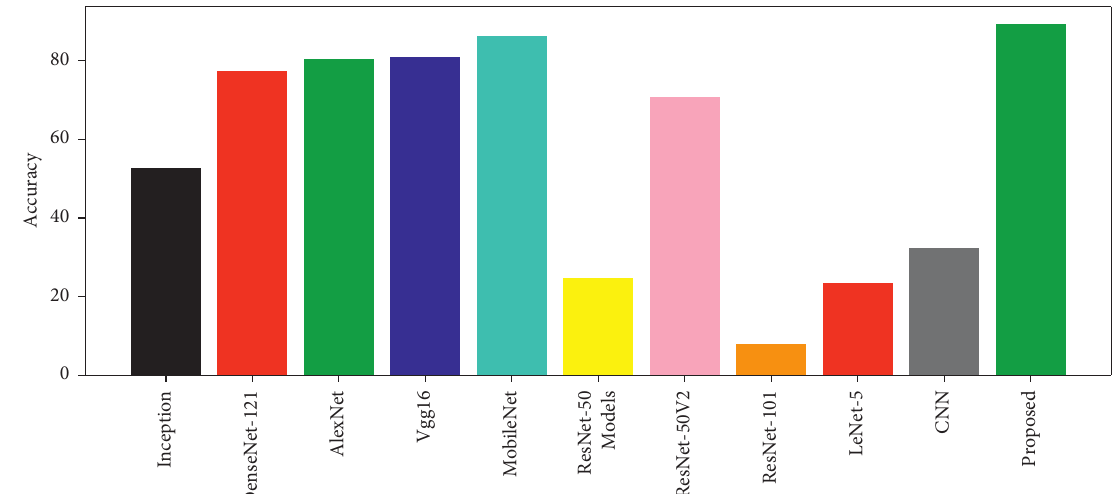
Figure 18: Comparison between the proposed and other